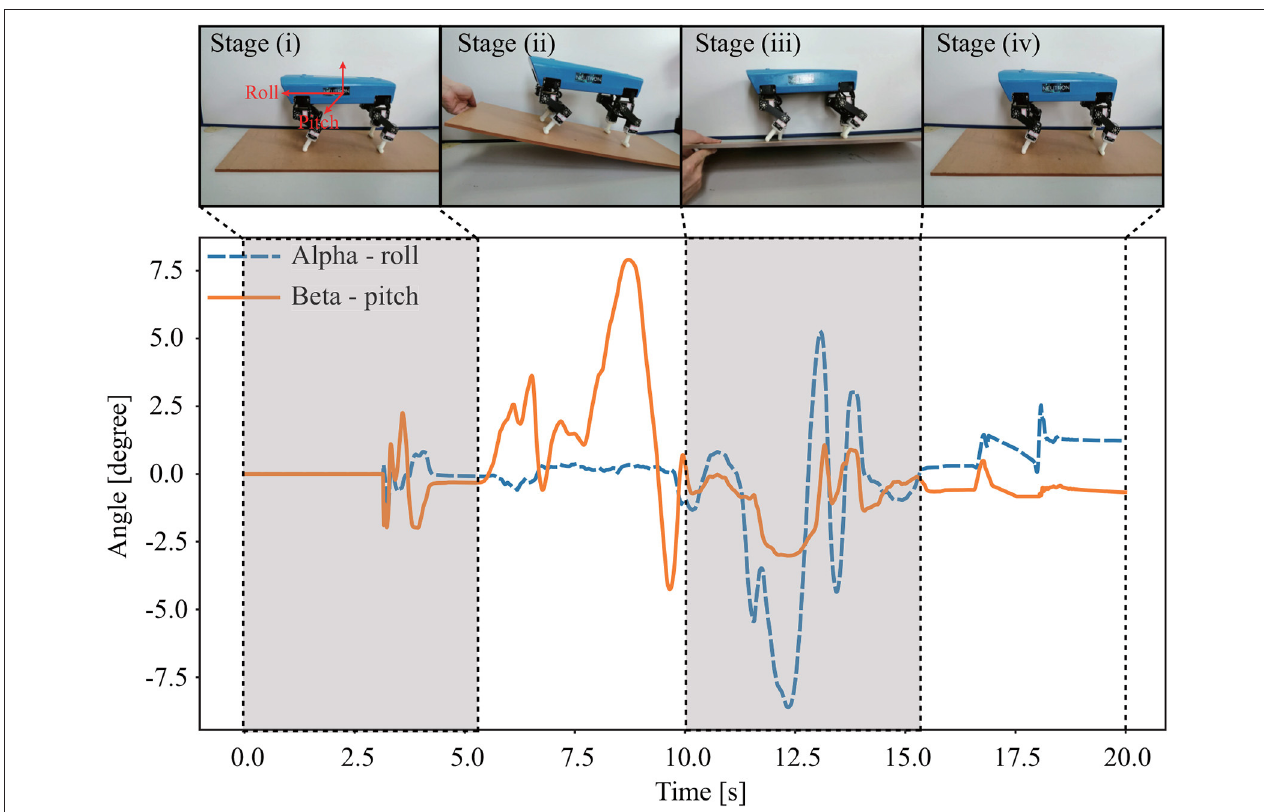
FIGURE 11 | Snapshot and body attitude angles of Lilibot in the experiment, where Lilibot sustained its body attitude stabilization while the supported tiltable plane inclined around the pitch and roll planes in stages (ii) and (iii),